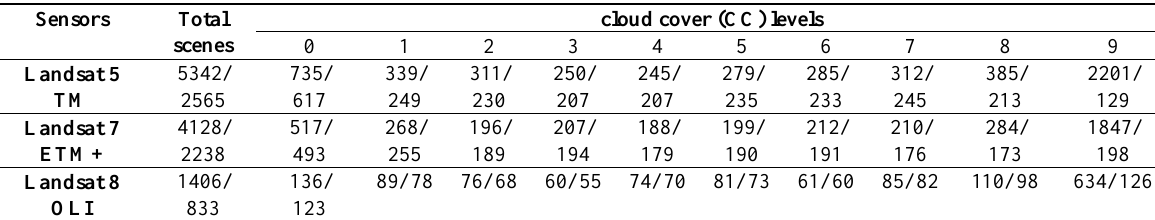
Table 2. Landsat TM, ETM+, and OLI scenes acquisition statistics in TGRA and the number of scenes at varies cloud cover (CC) levels (0–9) from April 1986 to January 2019. (Note: Statistics that do not contain Tier 2 data sets are behind the